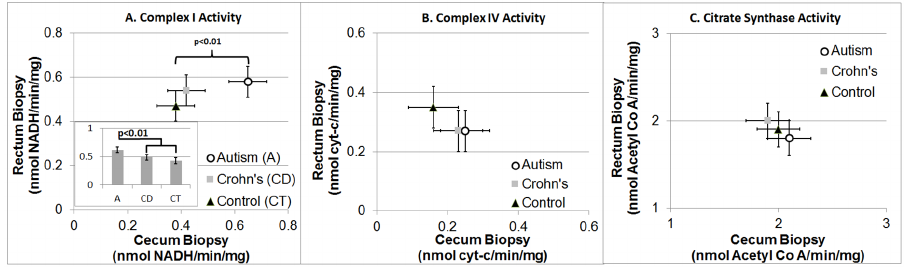
Fig 5. Electron Transport Chain Complex I and IV and Citrate Synthase Activity. Overall complex I activity is greater in the autism group as comparedto the two control groupsin both the rectum and cecum, when (A) the three groups are analyzedindividually.Error bars represent standarderror. ASD = Autism Spectrum Disorder.